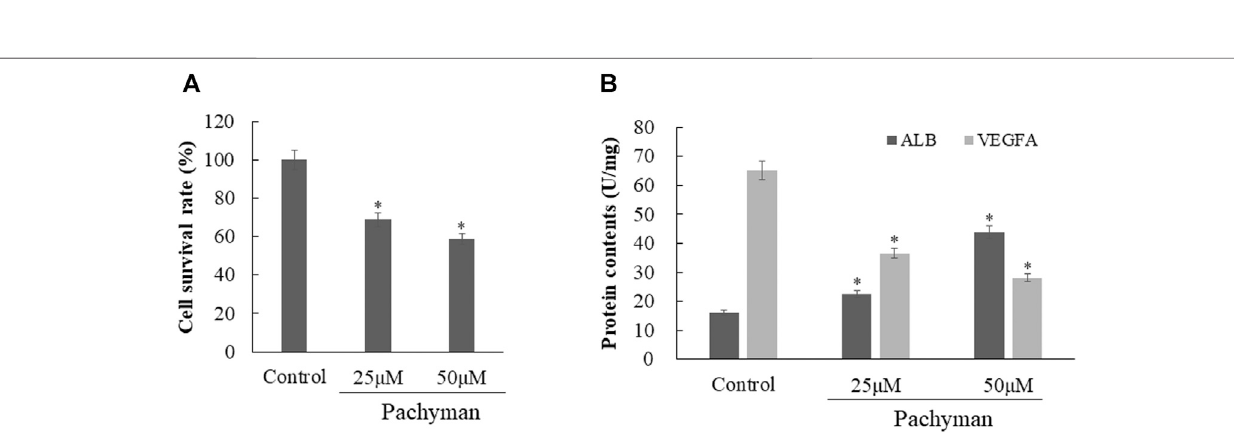
Frontiers in Pharmacology |